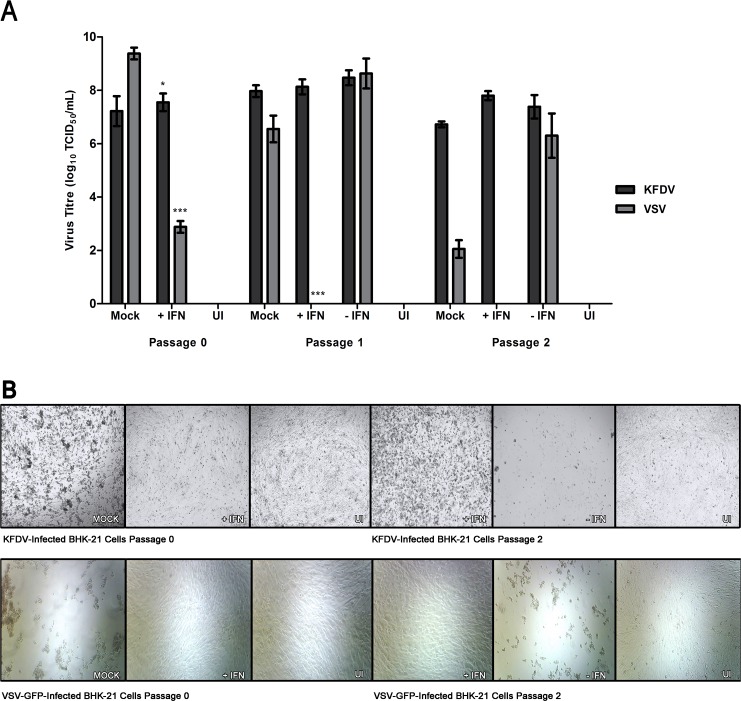
IFN-α2a does not clear KFDV infection in BHK-21 cells.BHK-21 cells were infected with a 11 TCID50 units (MOI of 0.00001) of the indicated virus, and either treated or mock-treated with 2, 000 U/mL of IFN-α2a (designated as P0). Monolayers were passaged when untreated controls reached CPE of 90%, 96 and 48 hpi for KFDV and VSV-GFP, respectively and 2, 000 U/mL of IFN-α2a was either added or omitted (P1) and after 72 hpi for KFDV and 48 hpi for VSV-GFP. This procedure was repeated again for passage 2 (P2). (A) Before each passage, supernatants were harvested for titration by TCID50 assay determination on BHK-21 cells. The averages and standard deviation from three biological replicates are shown graphically and expressed in log10 scale TCID50/mL. Statistical significance is denoted as * P < 0.1, ** P < 0.05, *** P < 0.01. (B) Cell monolayers were visualized with light microscopy prior to passaging Cell monolayers were photographed prior to passaging. Mock, non-IFN treated/infected controls. UI, Un-infected controls.